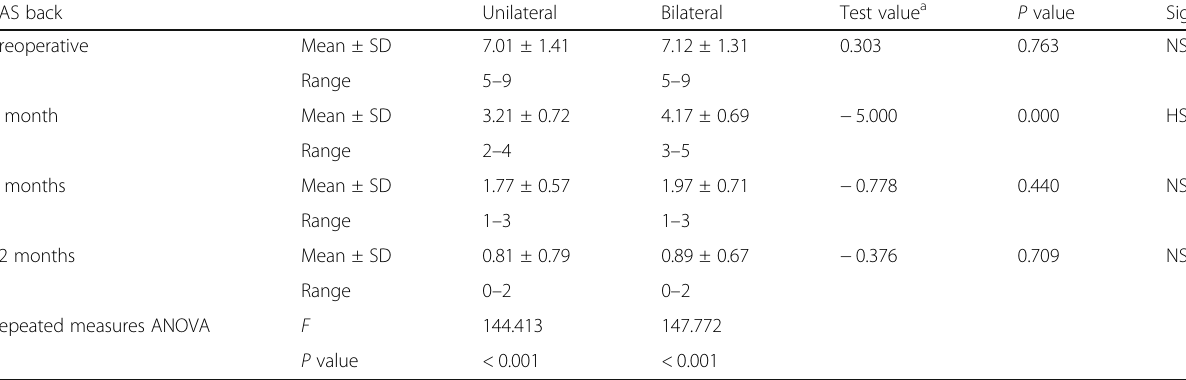
Table 1 Comparison between unilateral group and bilateral group regarding the visual analogue scale for back pain VAS back Unilateral